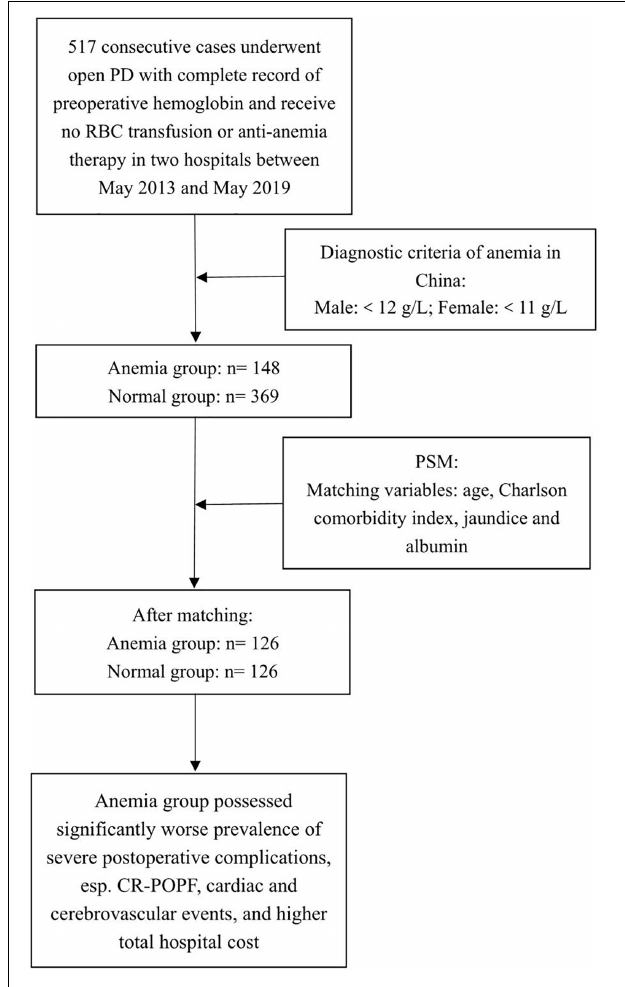
FIGURE 1 | Flowchart of the